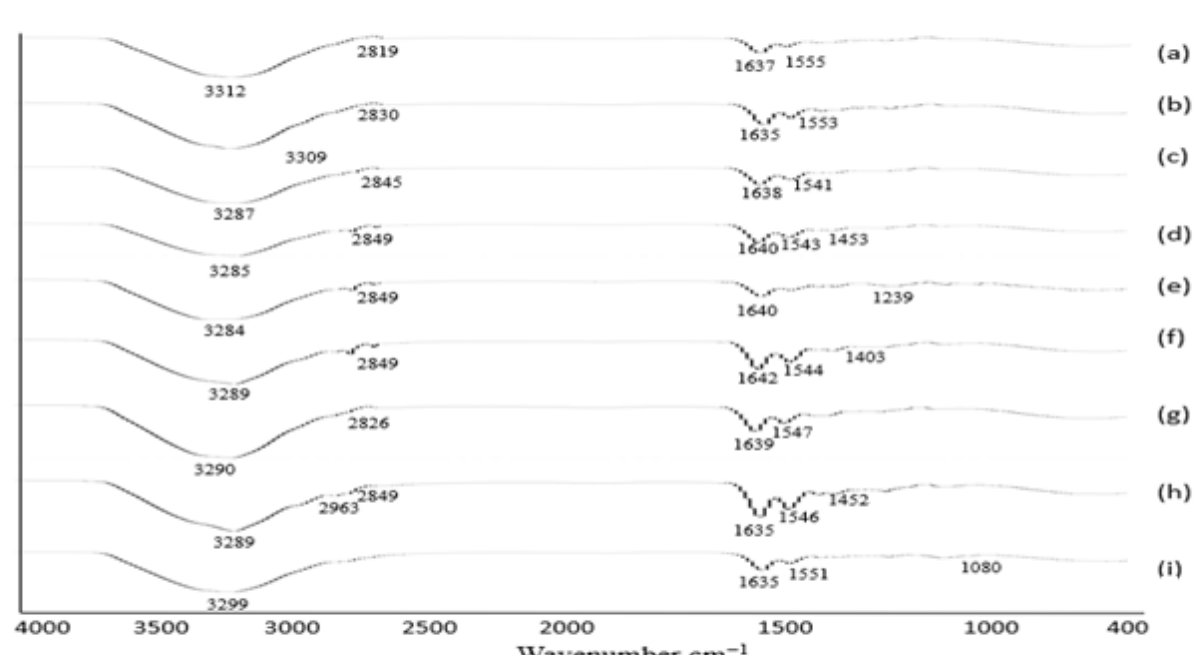
Figure 6. ATR-FTIR of skin epidermis: ( a ) blank skin, ( b ) skin treated with formulation VRZNA, ( c ) skin treated with formulation VRZNB, ( d ) skin treated with formulation VRZNC, ( e ) skin treated with formulation VRZND, ( f ) skin treated with formulation VRZNE, ( g ) skin treated with formulation VRZNF, ( h ) skin treated with formulation VRZNG, and ( i ) skin treated with pure drug.